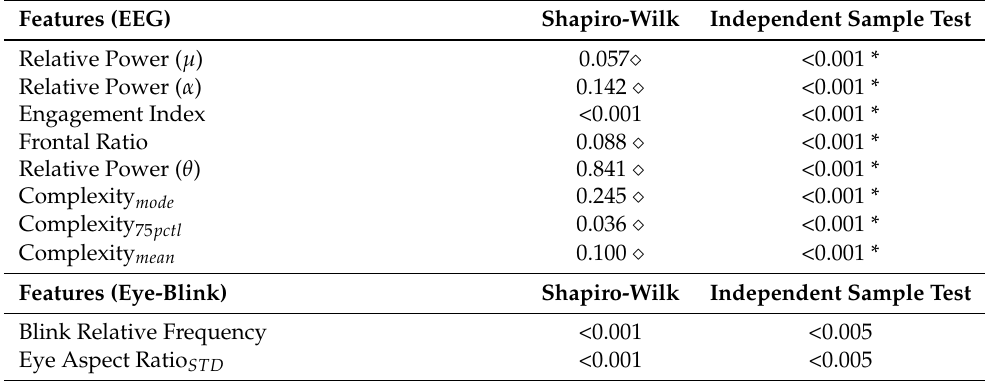
Figure 9. Importance scores of the selected features, computed through the ReliefF algorithm. Table 7. Descriptive and Independent Samples Statistics of the features employed in the classification. The (cid:5) mark represents normal features, the * represents significant features (95% confidence